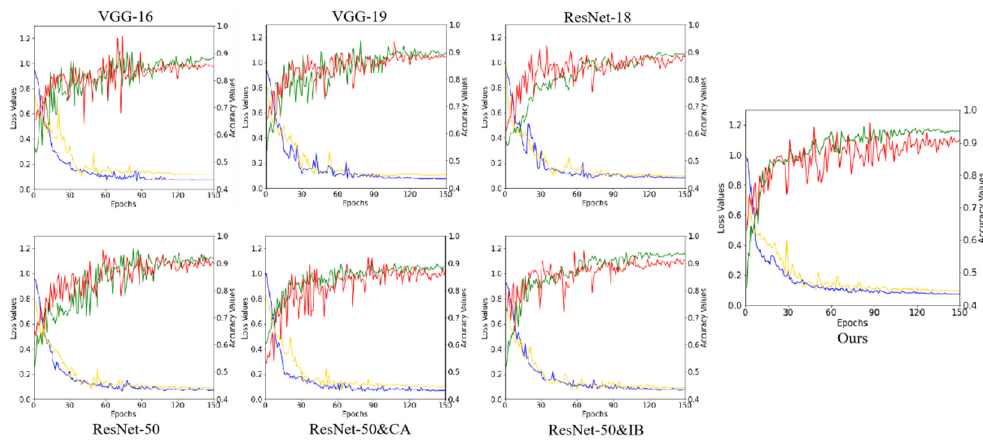
Figure 6. The loss and accuracy of the methods in the experiment. The green line represents the training accuracy. The red line represents the validation accuracy. The blue line represents the training loss. The yellow line represents the validation loss.